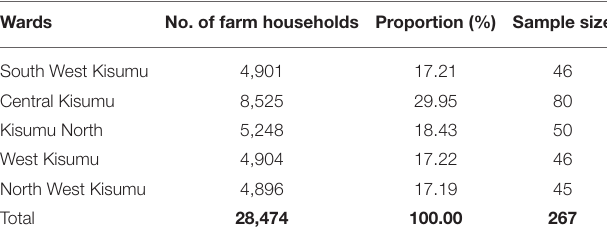
TABLE 1 | Proportionate sample size distribution per ward in the study